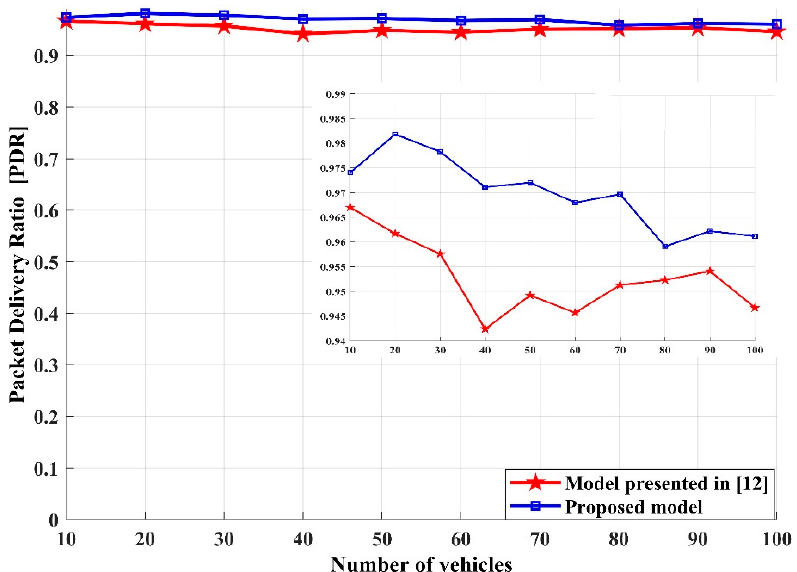
Figure 14. Packet delivery ratio (PDR) vs. number of vehicles at variable vehicles’ velocity.